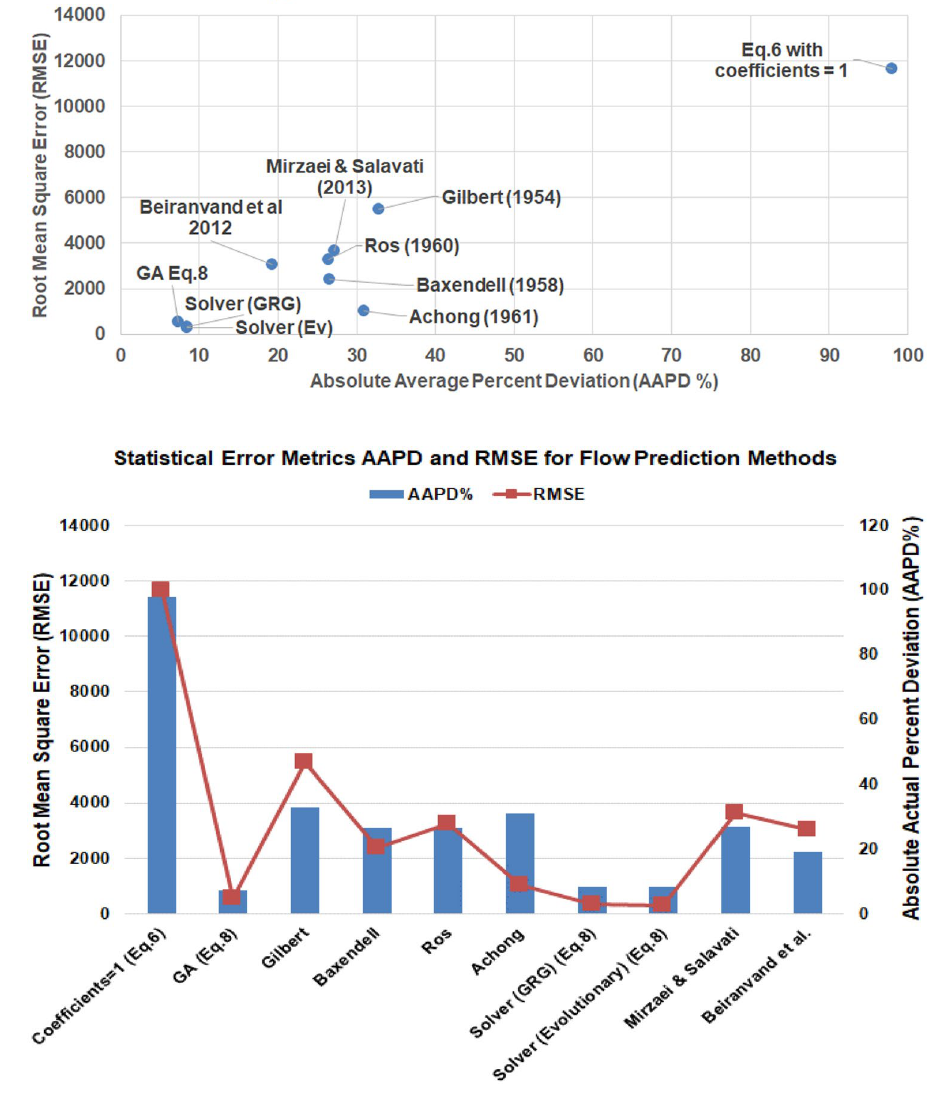
Fig. 11 A comparison between root-mean-square error (RMSE) and absolute average percent deviation (AAPD%) for the Reshadat oil field applying GA and Solver optimization to Eqs. (6), (8), and (19) for the published liquid flow-rate prediction formulas proposed by this study and by Gilbert (1954), Baxendell (1958), Ros (1960), Achong (1961), Beiranvand et al. (2012), and Mirzaei-Paiaman and Salavati (2013) to the test data subset (55 data records)